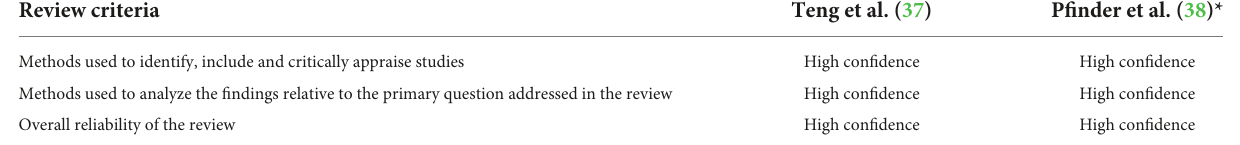
TABLE 5 Risk of bias of systematic